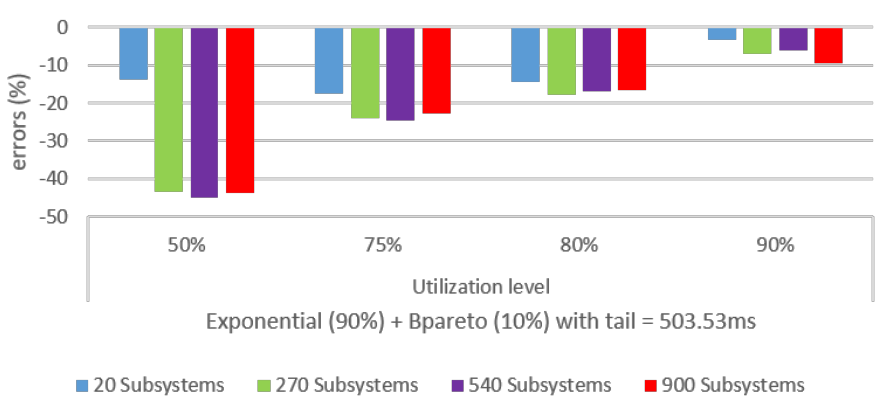
Figure 7. HFJQNs of applying 90% homogeneous (exponential) and 10% inhomogeneous (bounded Pareto) for all fork nodes, where the black-box method is used in the solution.